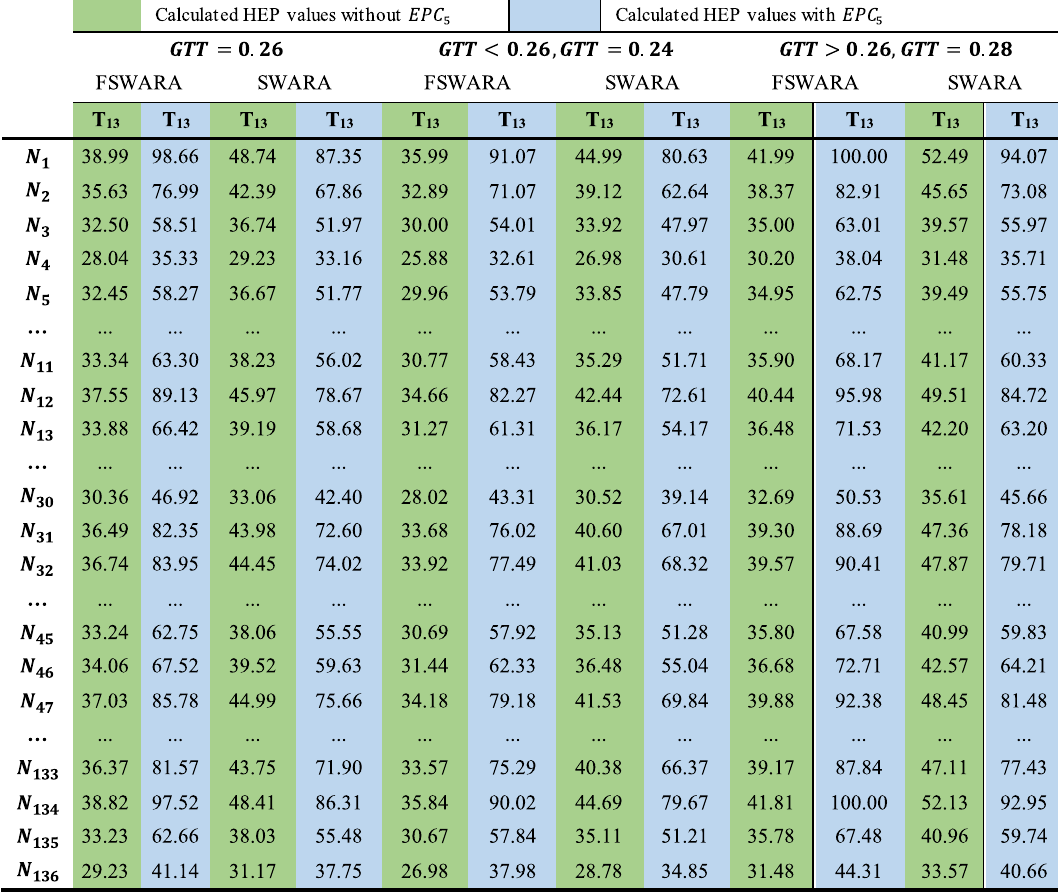
Table 13 Comparative HEP values for EPC